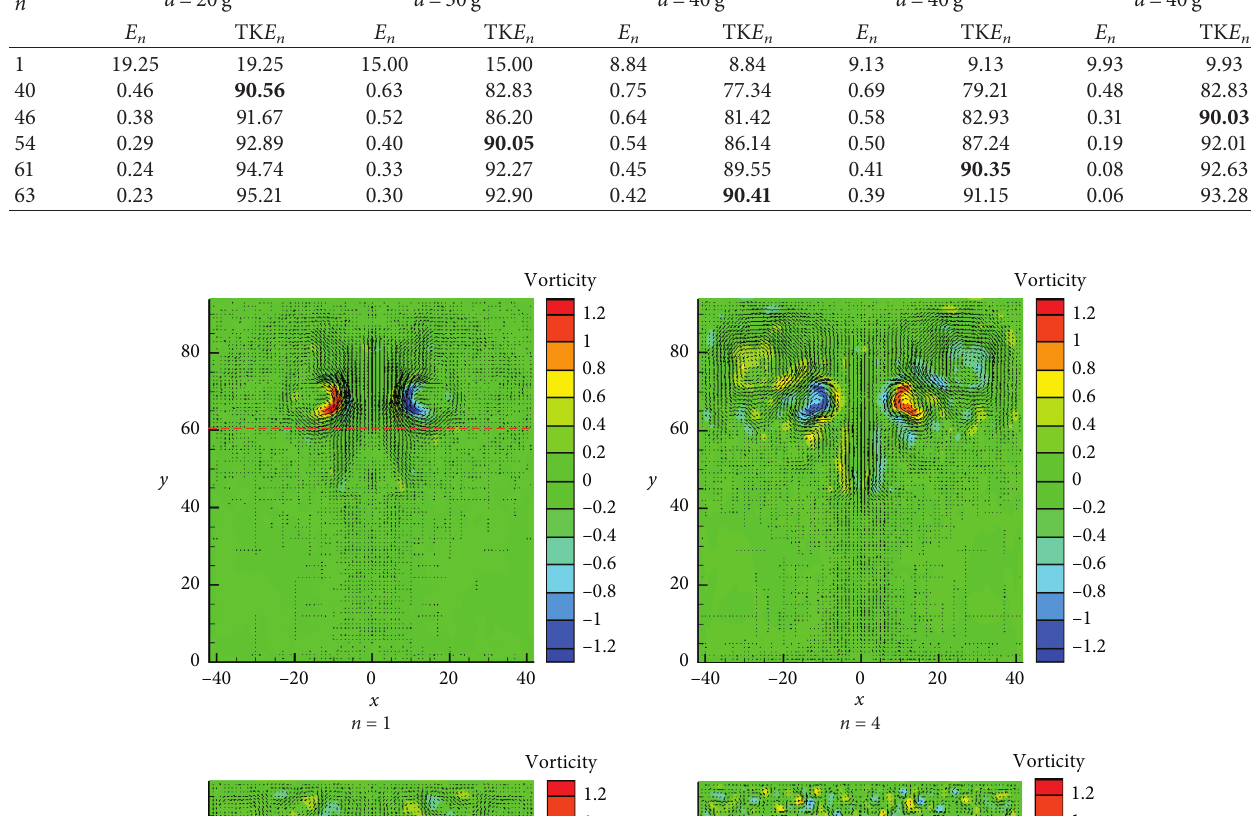
Table 2: The energy distribution E n of the n th mode and the cumulative contribution TK E n of the first n modes. 70% fill level n